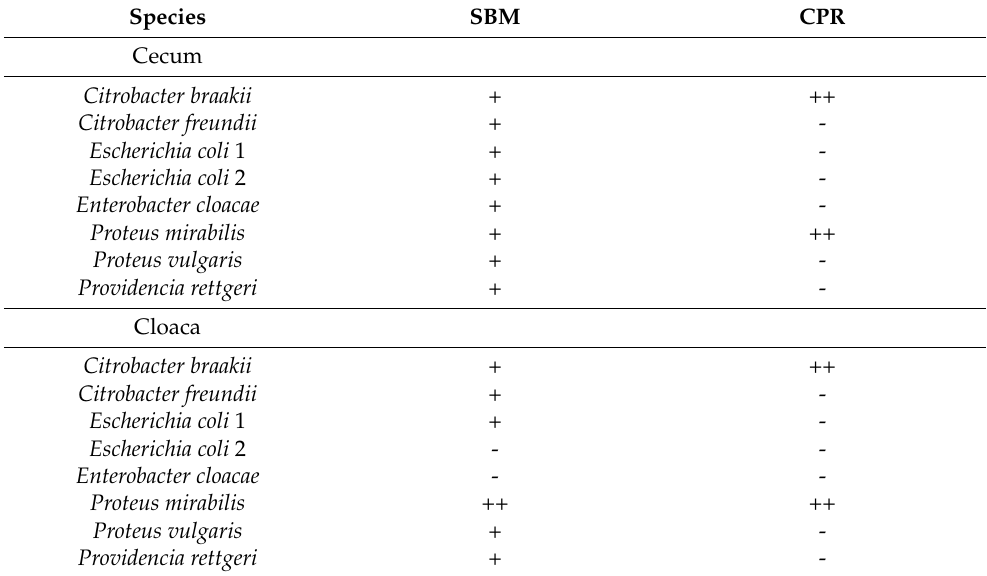
Table 7. Enterobacteriaceae species isolated from the cecum and cloaca of broiler chickens at day 42 1